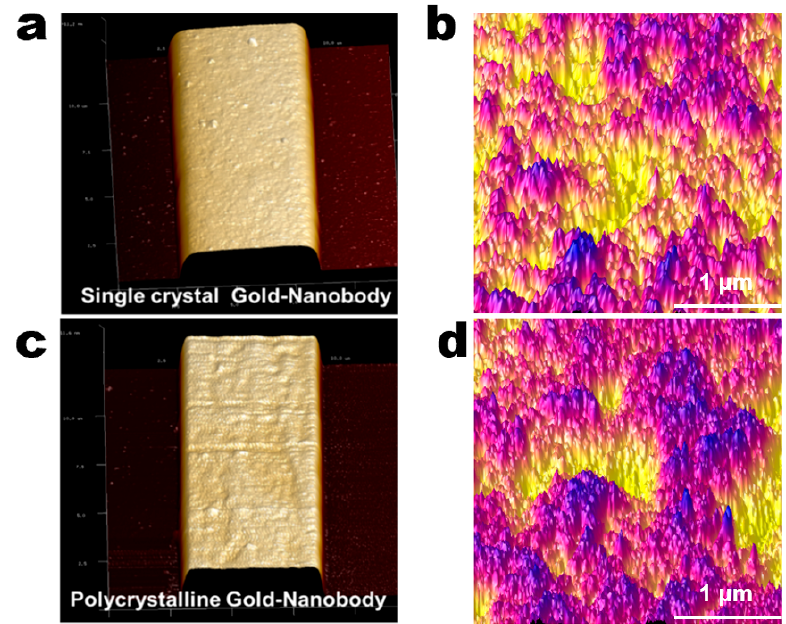
Figure 4. The AFM images of the single-crystal and polycrystalline gold-electrode-modified Nbs. ( a ) Single-crystal gold film (20 μ m × 20 μ m) was characterized for morphology using AFM; ( b ) sur- face morphology of single-crystal gold film modified Nbs (3 μ m × 3 μ m); ( c ) polycrystalline gold film (20 μ m × 20 μ m) was characterized for morphology using AFM; ( d ) surface morphology of polycrystalline gold film modified Nbs (3 μ m × 3 μ m).